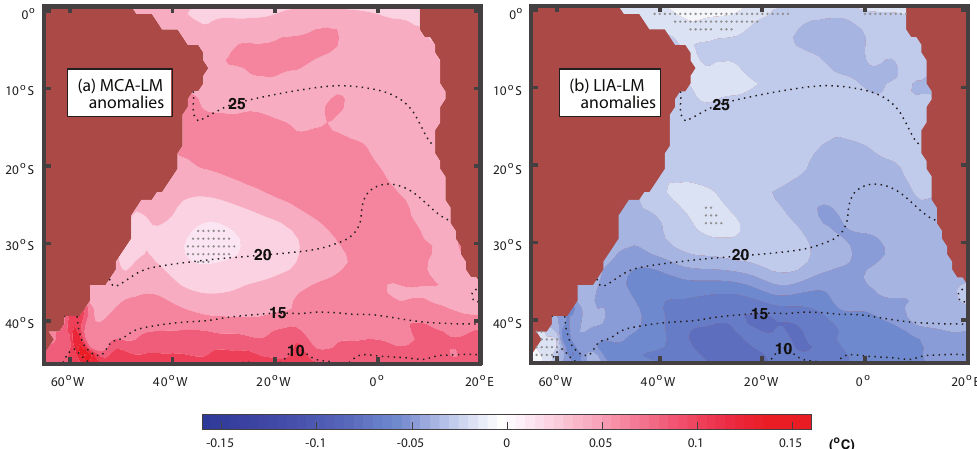
Figure 1. Sea surface temperature anomalies ( ◦ C) with respect to the whole Last Millennium (LM) base period (850–1849). ( a ) For the Medieval Climate Anomaly (MCA), between 950 and 1249, and ( b ) for the Little Ice Age (LIA), between 1400 and 1699. The black dashed contours represent the LM-mean SST values, for reference. Red (blue) colors represent positive (negative) anomalies. Gray hatched areas indicate non-significant MCA/LIA-LM anomalies according to a two-sided t -test ( p <